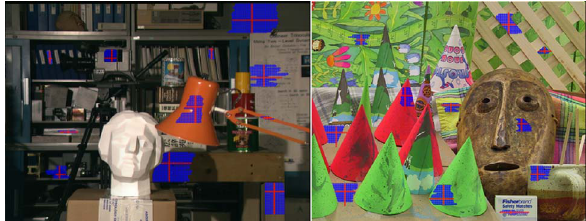
Figure 6. Examples of the regions formed with the linear ap- proach for the generation of cross-based